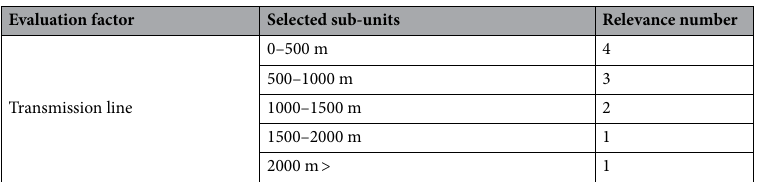
Table 1. Solar power plant scoring values created by experts for each layer.